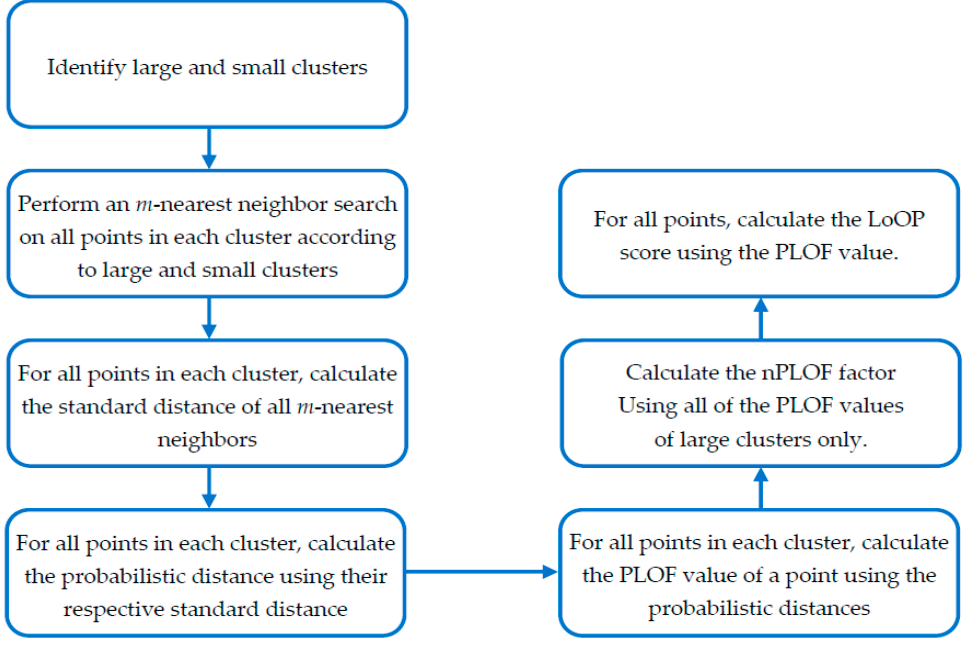
Figure 4. Overview of the adapted CLOP algorithm.